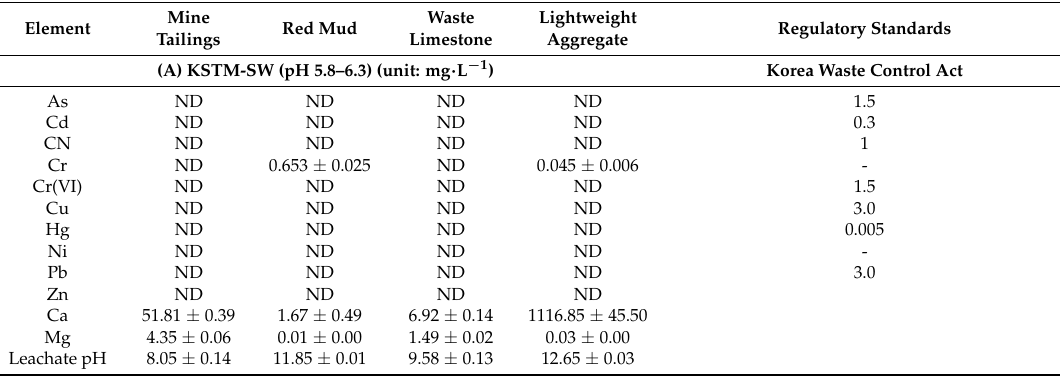
Table 3. Leaching characteristics of the mine tailings, red mud, and waste limestone in comparison with regulations from Korea, the US, and